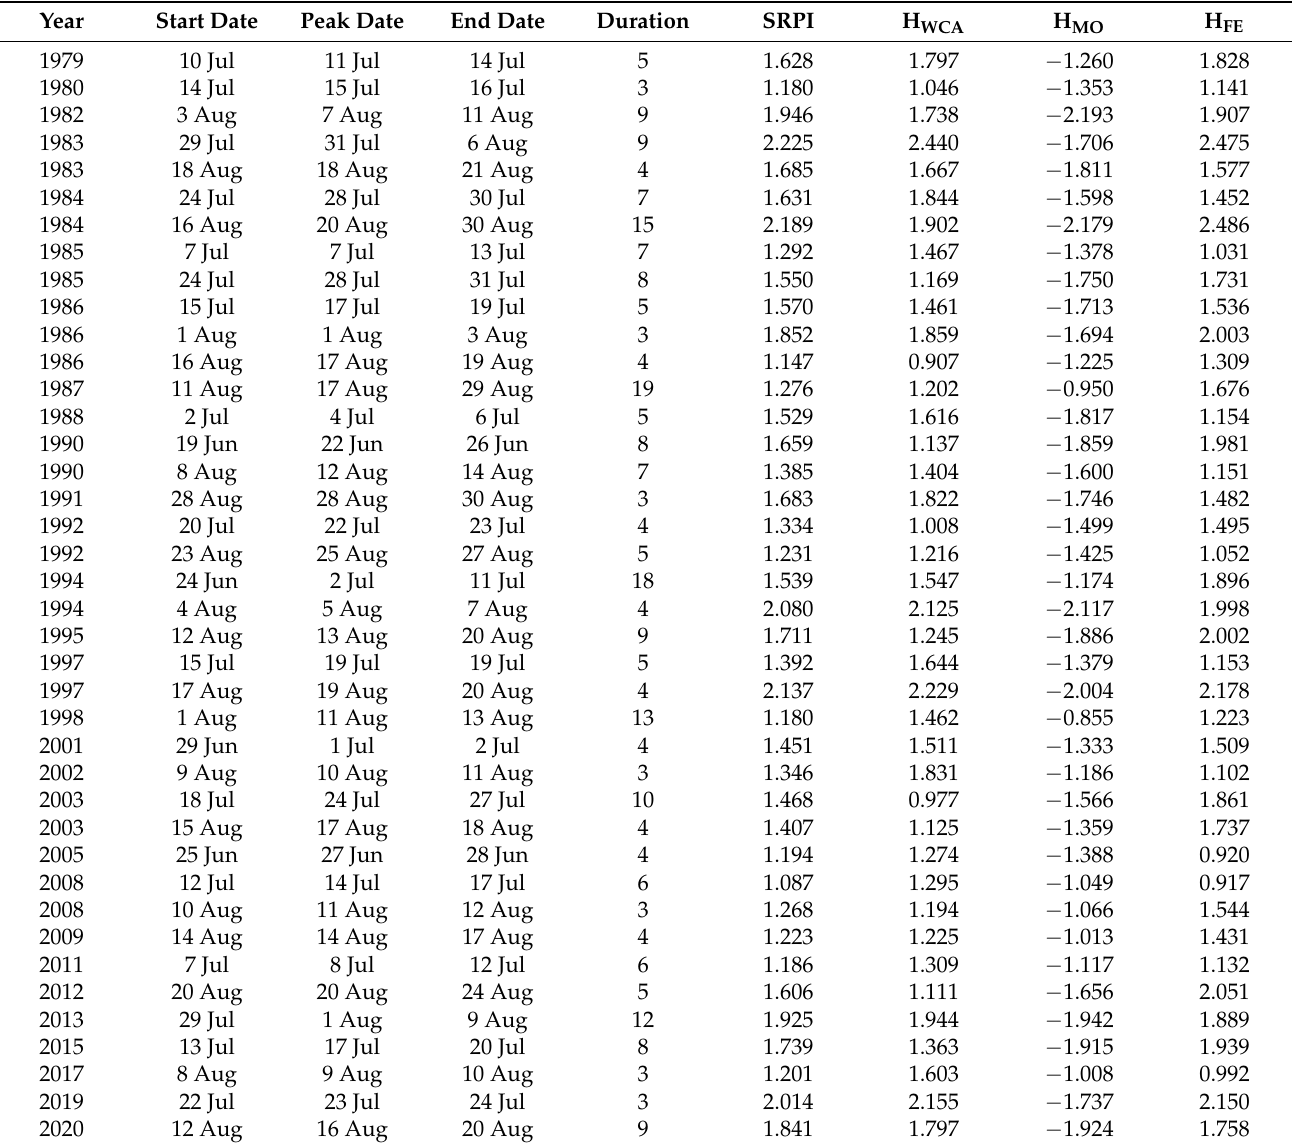
Table 1. The year, start date, peak date, end date, duration (unit: day), average SRPI, and H WCA , H MO , H FE of the 40 SRP+